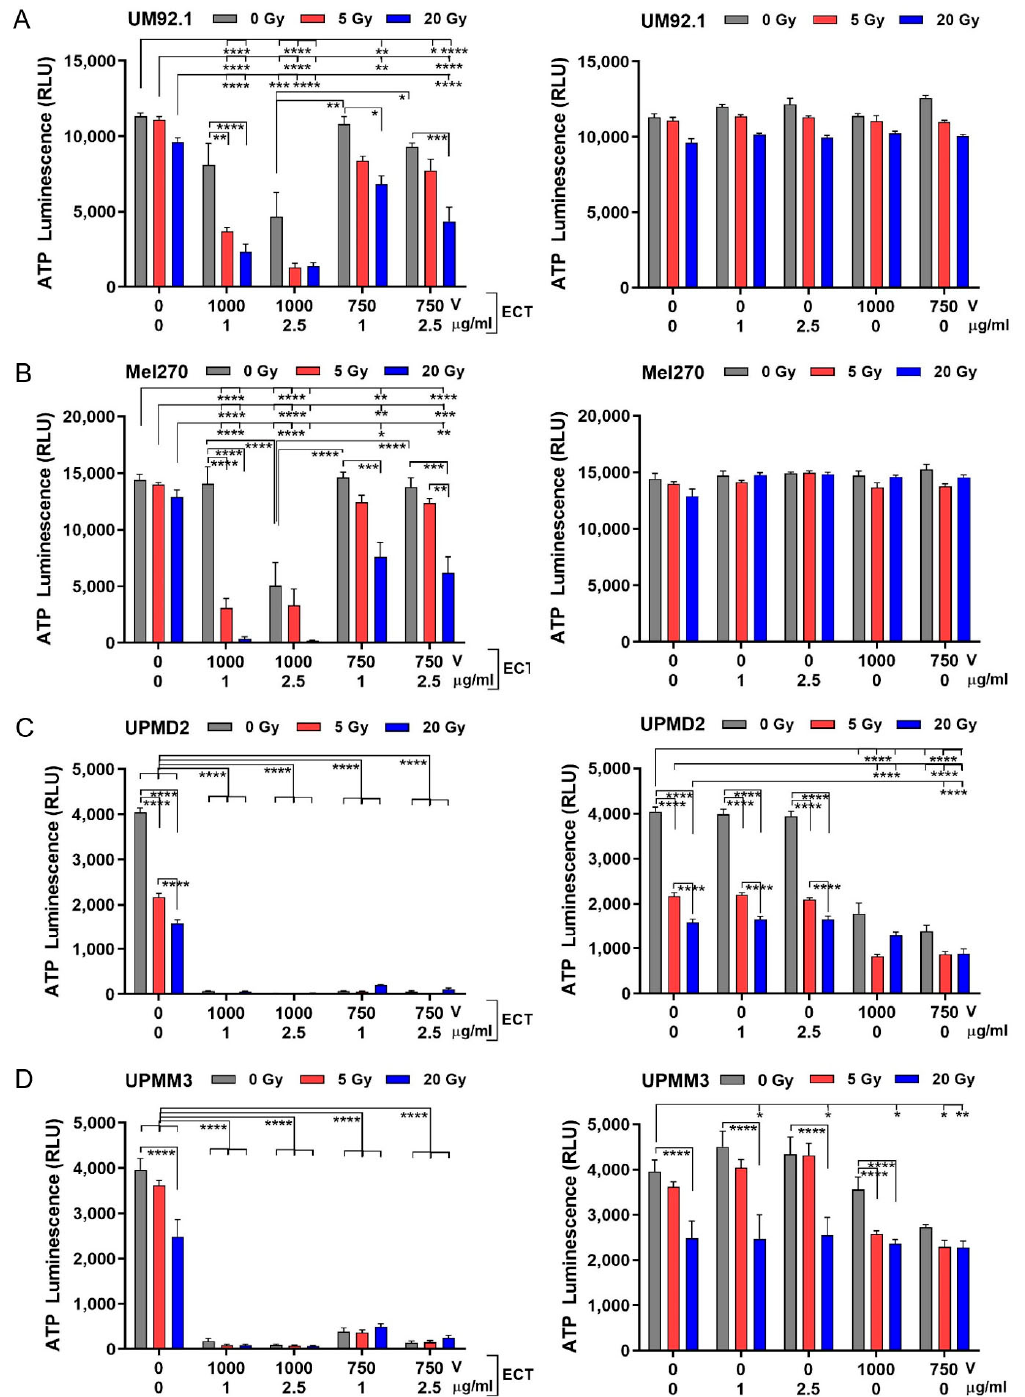
Figure 4. Cytotoxic effects of radiation and ECT on 3D spheroid viability. ( A ) UM92.1 spheroids, ( B ) Mel270 spheroids, ( C ) UPMD2 spheroids and ( D ) UPMM3 spheroids were irradiated (dose 5 or 20 Gy) or treated with ECT (electroporated 1000 V or 750 V in the presence of 1 µg/mL or 2.5 µg/mL bleomycin) or spheroids were irradiated followed by ECT (left side of the graphs). In addition, tumor spheroids were treated with bleomycin (1 µg/mL or 2.5 µg/mL) or electroporation (1000 V or 750 V) alone (right side of the graphs). Cytotoxic effects on spheroid viability ( n = 5–8) were assessed by measuring the ATP content of lysed spheroid cells using a 3D cell viability assay (ATP Luminescence, RLU Relative Light Units). Data are means ± SD. A statistical analysis was performed using a two-way ANOVA and Tukey’s multiple comparisons test; * p < 0.05, ** p < 0.01, *** p < 0.005, **** p < 0.001.